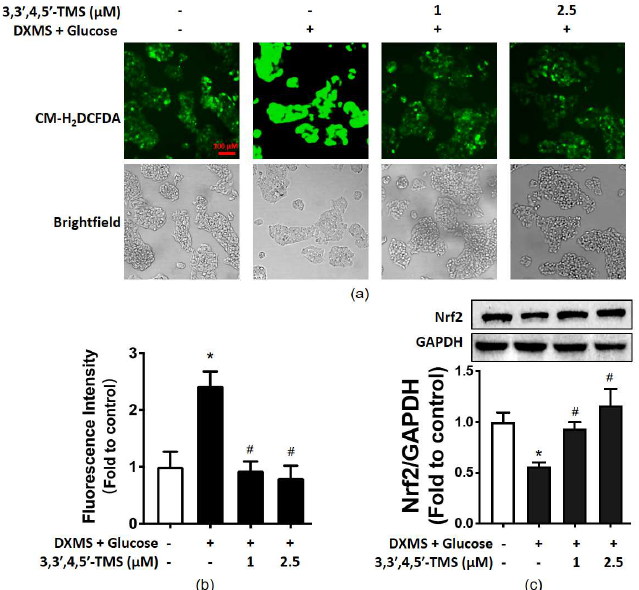
Figure 4. The effects of 3,3′,4,5′-TMS on oxidative stress. ( a ) Representative images and ( b ) summa- rized data showing CM-H 2 DCFDA intensity in IR-HepG2 cells pre-treated with high glucose (50 mM) and DXMS (30 µM) for 48 h and treated with 3,3′,4,5′-TMS for another 16 h. ( c ) Protein expressions of Nrf2 in IR-HepG2 cells. Values are the means ± SEM ( n = 3); * p < 0.05 vs. Control; # p < 0.05 vs. DXMS + glucose.